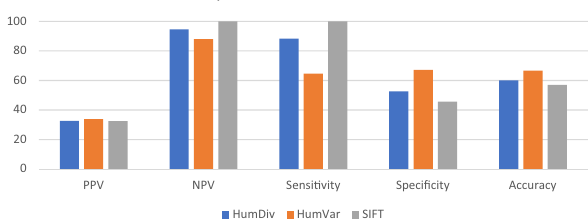
Figure 1. Performance metrics for SIFT, PolyPhen-2 HumVar and HumDiv predictions on BRCA1 variants with known clinical significance.